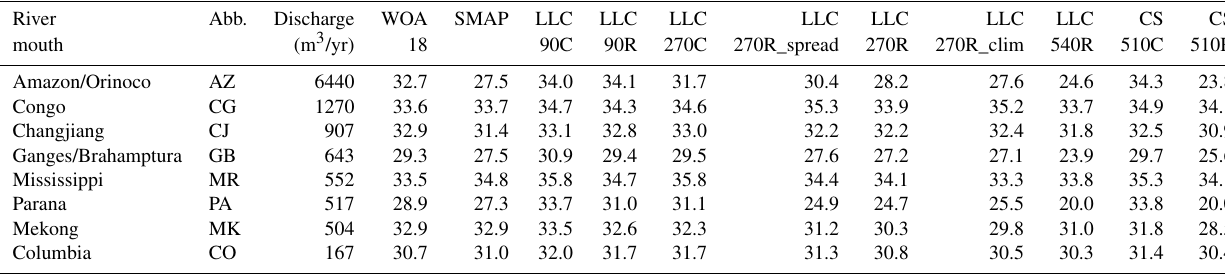
Table 2. The SSS near river mouth for WOA18, SMAP, and all experiments for the selected regions. River Abb.